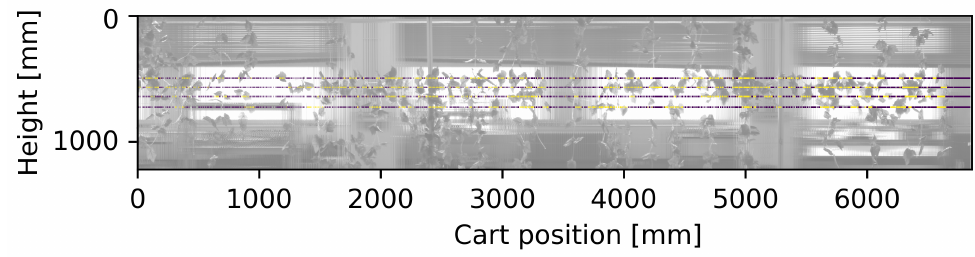
Figure 5. Collected data superimposed on the panoramic image of the synthetic